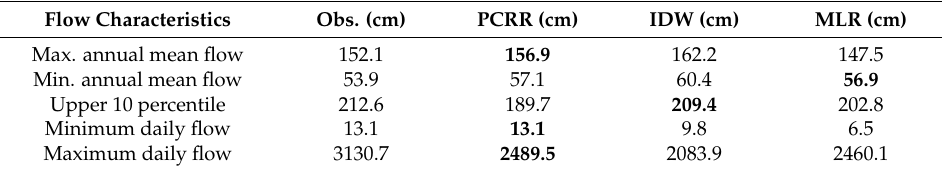
Table 7. Comparisons of flow characteristics.